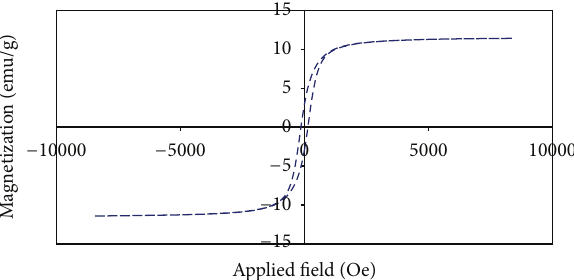
Figure 10: Hysteresis loop for Fe-V/SiO 2 nanocrystals at room temperature. Figure 11: Magnetic properties of optimal nanocatalyst can lead to its separation from the reaction medium.